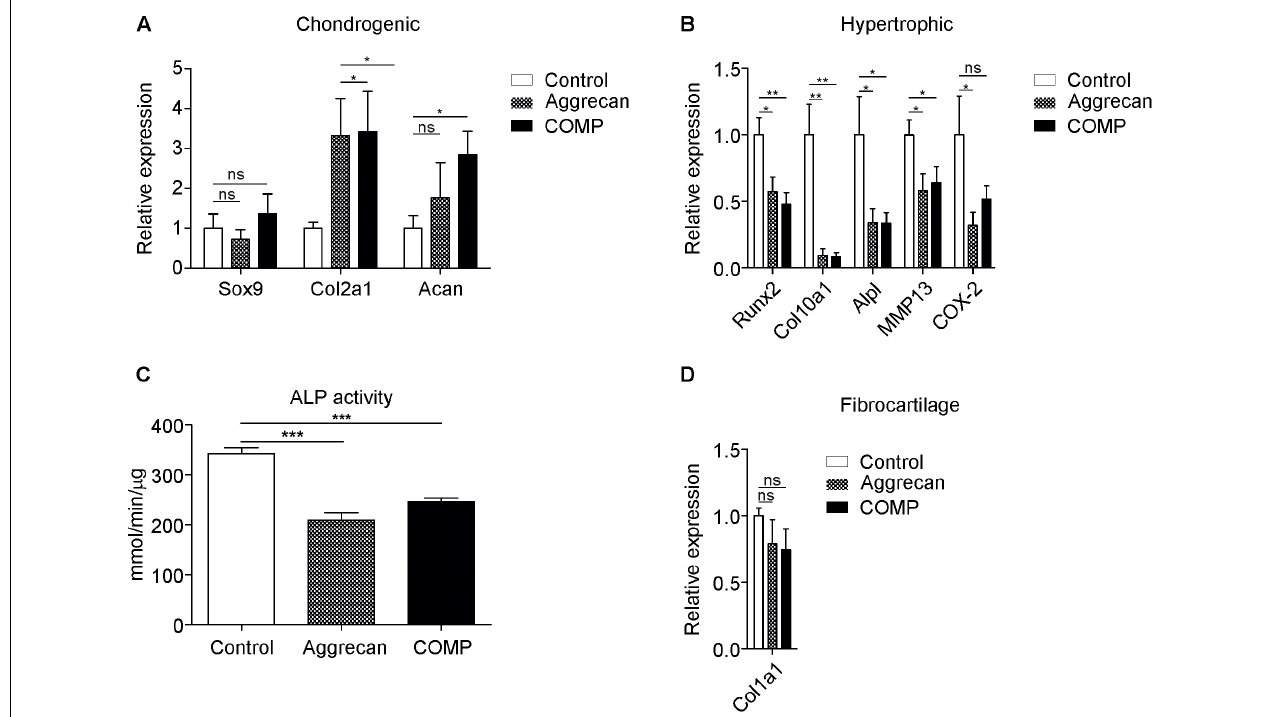
FIGURE 4 | Decreased hypertrophic marker expression in in vivo generated cartilage stimulated with Aggrecan or COMP. Cartilage formation was ectopically induced by injecting an agarose biogel ( n = 8) with or without the addition Aggrecan (2% w/v; n = 8) or COMP (0.5 mg/ml; n = 8) under the tibial periosteum of rabbits and after 14 days generated tissues were harvested for gene expression analysis. (A) Induction of chondrogenic markers Sox9, Col2a1, and Acan mRNA expression was determined by RT-qPCR and normalized for 28S rRNA expression. (B) Induction of hypertrophic markers Runx2, Col10a1, and Alpl mRNA expression was determined by RT-qPCR at day 14 and normalized for 28S rRNA expression. (C) ALP enzyme activity in tissue lysates of same conditions was determined and normalized to total protein content. (D) Fibrocartilage marker Col1a1 mRNA expression as determined by RT-qPCR and normalized to 28S rRNA expression. In graphs, error bars represent mean ± SEM. Statistically significant differences ( p < 0.05) are shown by an *, ** = p < 0.01, *** = p < 0.005, ns = not